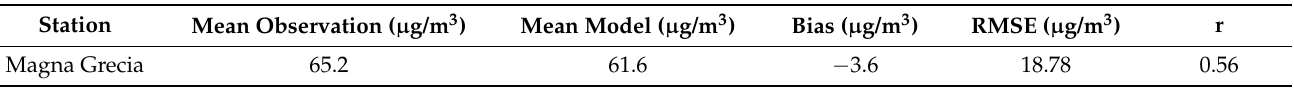
Table 4. Statistical evaluation of HMS (FARM + PMSS) performance for daily NO 2 values on Magna Grecia station.